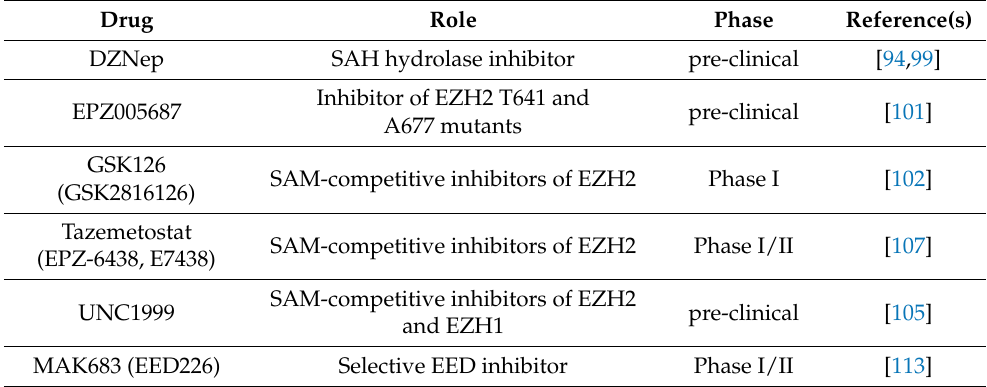
Table 4. Pre-clinical and clinical trial status of drugs related to